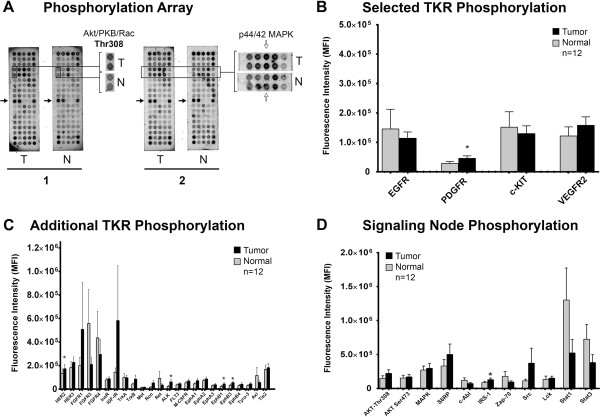
Quantification of basal TKR and signaling node phosphorylation of cpAC and normal lung tissue. (A) Representative captured fluorescent image of a slide with four phosphorylation array profiles from paired normal and tumor protein lysates of two dogs. Differences between tumor and normal tissue fluorescence intensities for Akt/PKB/Rac at Thr308 are highlighted in the array set from the first dog, whereas differences between tumor and normal tissue fluorescence intensities for p44/42 MAPK are highlighted in the array set from the second dog (white arrows). The black arrow represents one row of the array spotted with three positive (black spots) and two negative (non-colored spots) controls. The entire array has 10 positive controls. (B-D) The protein array measured the phosphorylation status of the selected TKRs that were evaluated using IHC as well as 24 additional TKRs and 11 downstream signaling nodes. The phosphorylation measurement of PDGFR includes pan phosphorylation of both the alpha and beta forms of this receptor. Spot intensities were quantified using ImageQuant™ TL array analysis software. Each bar represents the mean fluorescence intensities obtained and therefore phosphorylation of 12 tumor (black) and 12 normal (grey) normal lung lysates from each dog. Error bars, mean ± SEM. *cpAC vs. normal: P < .05.